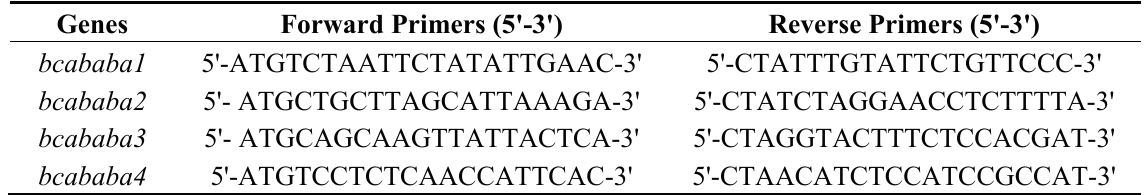
Table 2. Primer pairs used for cDNA